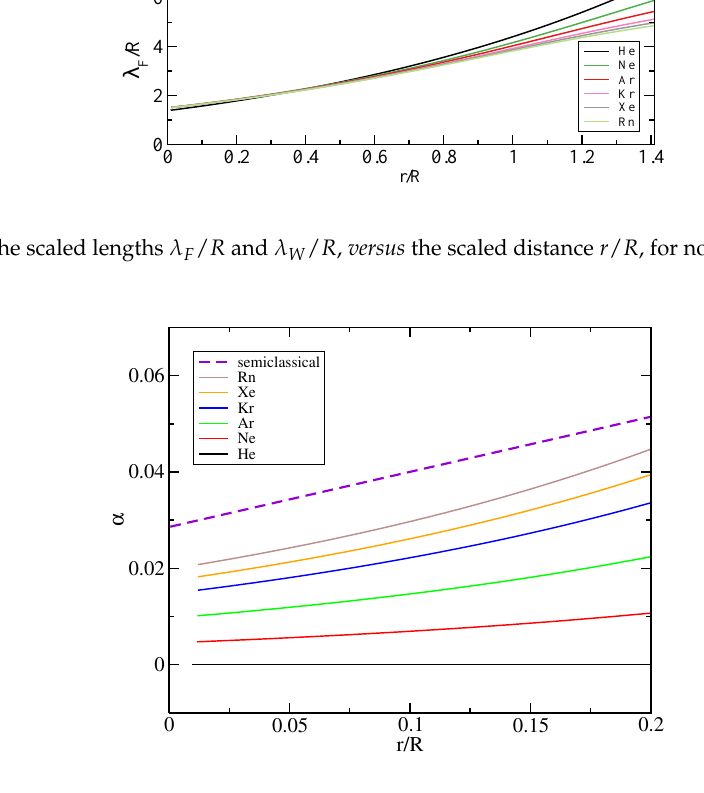
Figure 5. α versus the scaled radial distance r / R , near the nucleus of noble